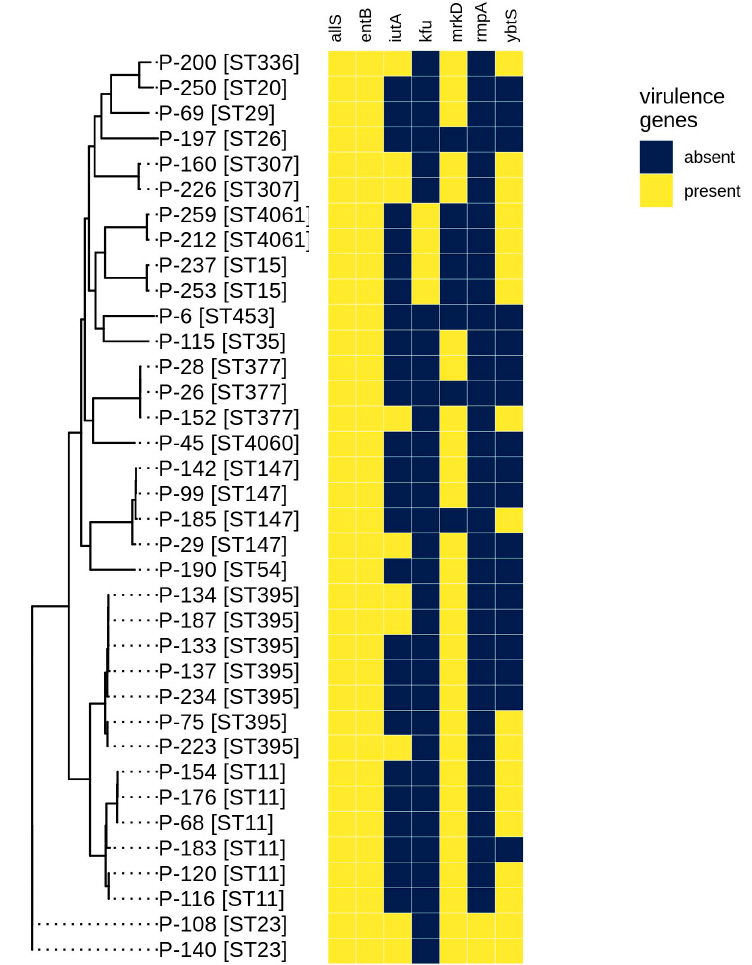
Figure 3. Virulence gene presence for the isolates studied revealed by bioinformatics methods.